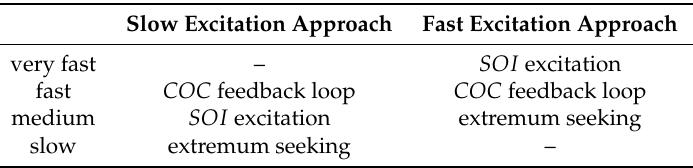
Table 4. Time scales of the two